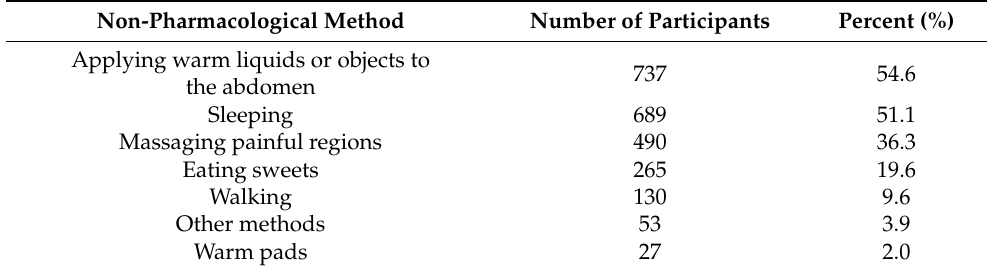
Table 2. Non-pharmacological Methods ( n = 1349).